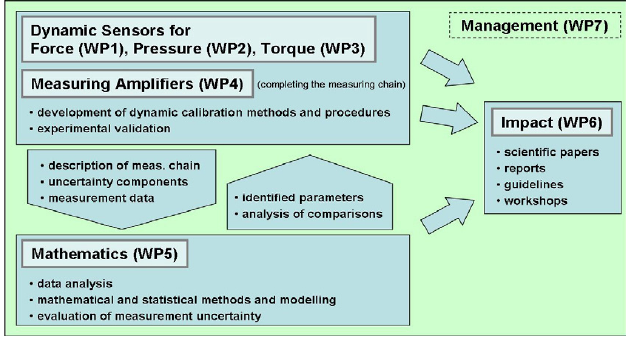
Fig. 1. Coordination and interaction between work